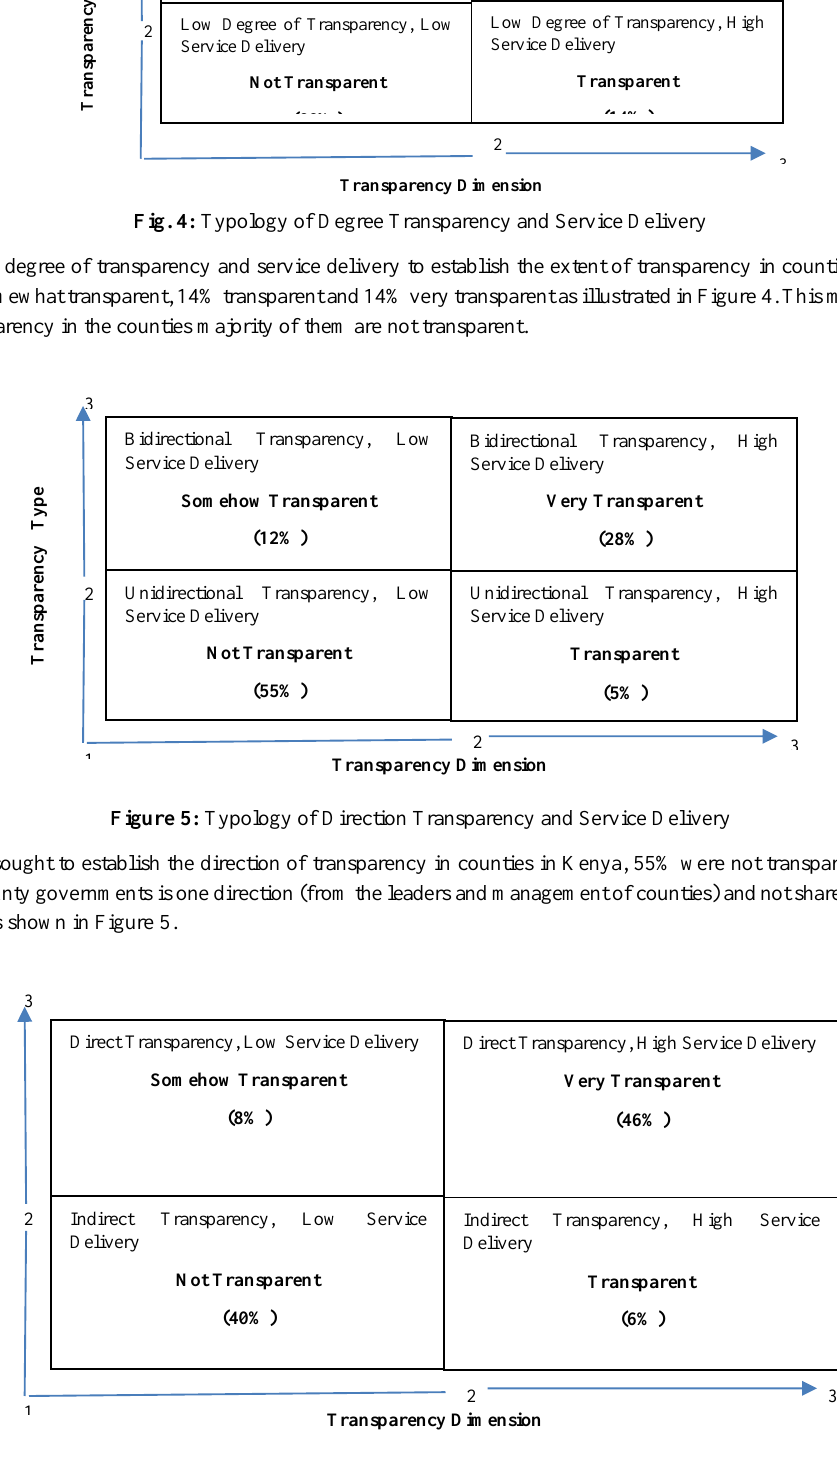
Fig. 6: Typology of Distribution Transparency and Service